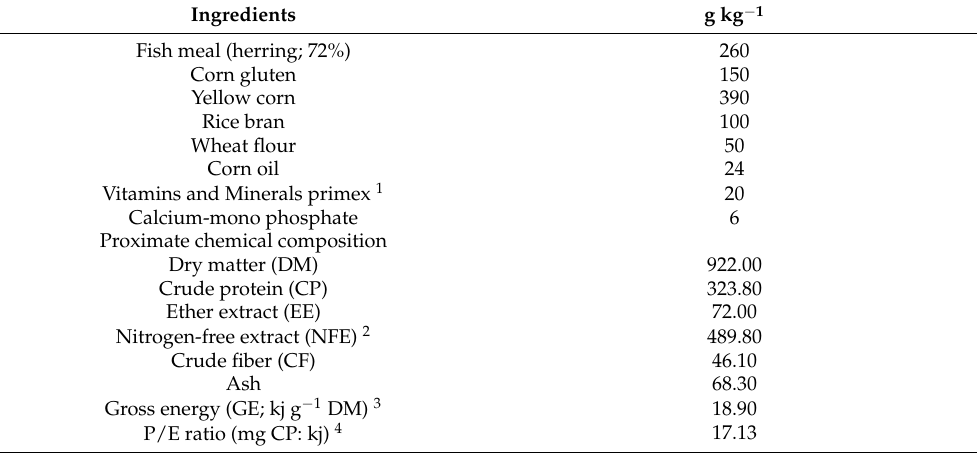
Table 1. Ingredients and proximate composition (g kg − 1 dry weight) of the experimental diet.